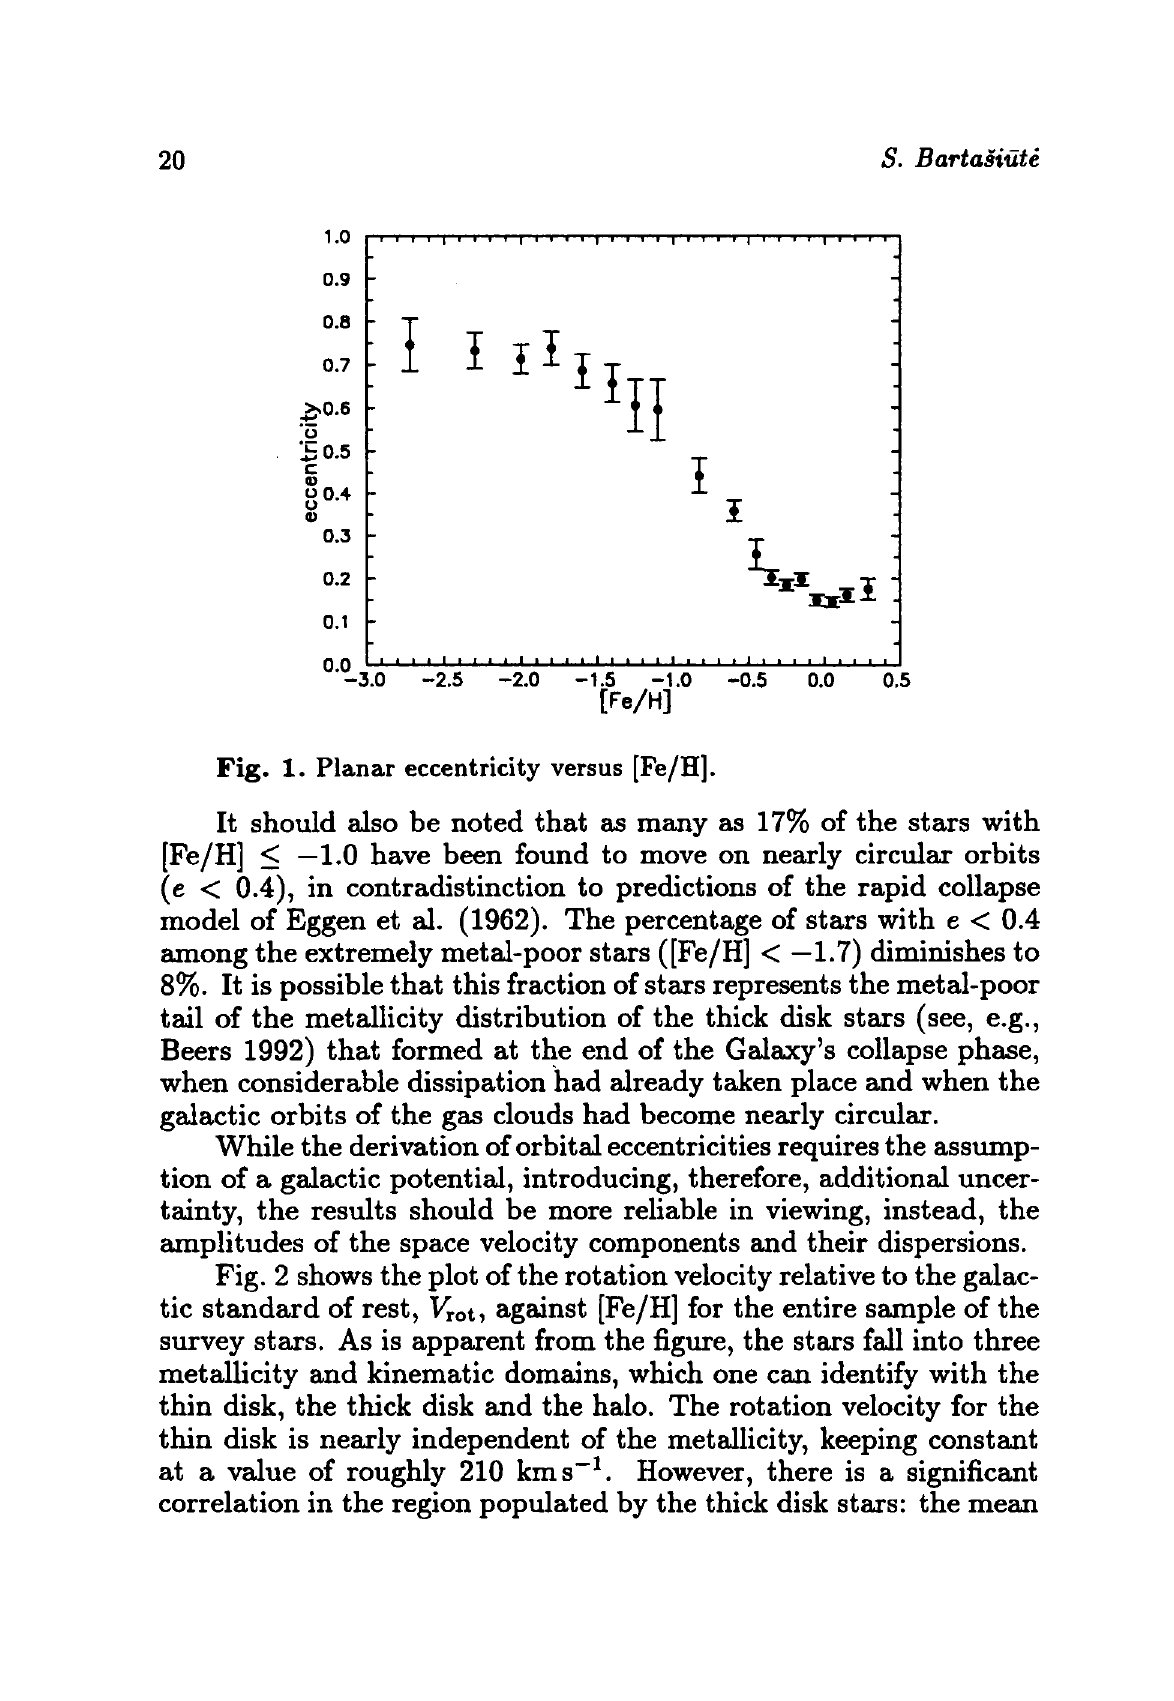
Fig. 1. Planar eccentricity versus [Fe/H]. It should also be noted that as many as 17% of the stars with [Fe/H] < —1.0 have been found to move on nearly circular orbits (e < 0.4), in contradistinction to predictions of the rapid collapse model of Eggen et id. (1962). The percentage of stars with e < 0.4 among the extremely metal-poor stars ([Fe/H] < —1.7) diminishes to 8%. It is possible that this fraction of stars represents the metal-poor tail of the metallicity distribution of the thick disk stars (see, e.g., Beers 1992) that formed at the end of the Galaxy's collapse phase, when considerable dissipation had already taken place and when the galactic orbits of the gas clouds had become nearly